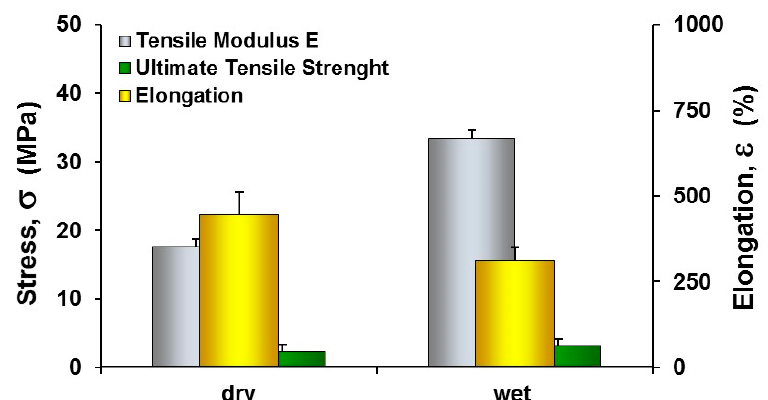
Figure 4. Mechanical properties of PCL HF membranes in dry and wet conditions. The values are the means of 10 measurements per sample ± SD.